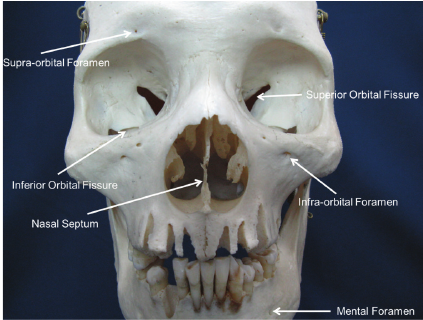
Figure 2: An example of a trophy image, unlocked after successful completion of one of the online quizzes (dry specimen).